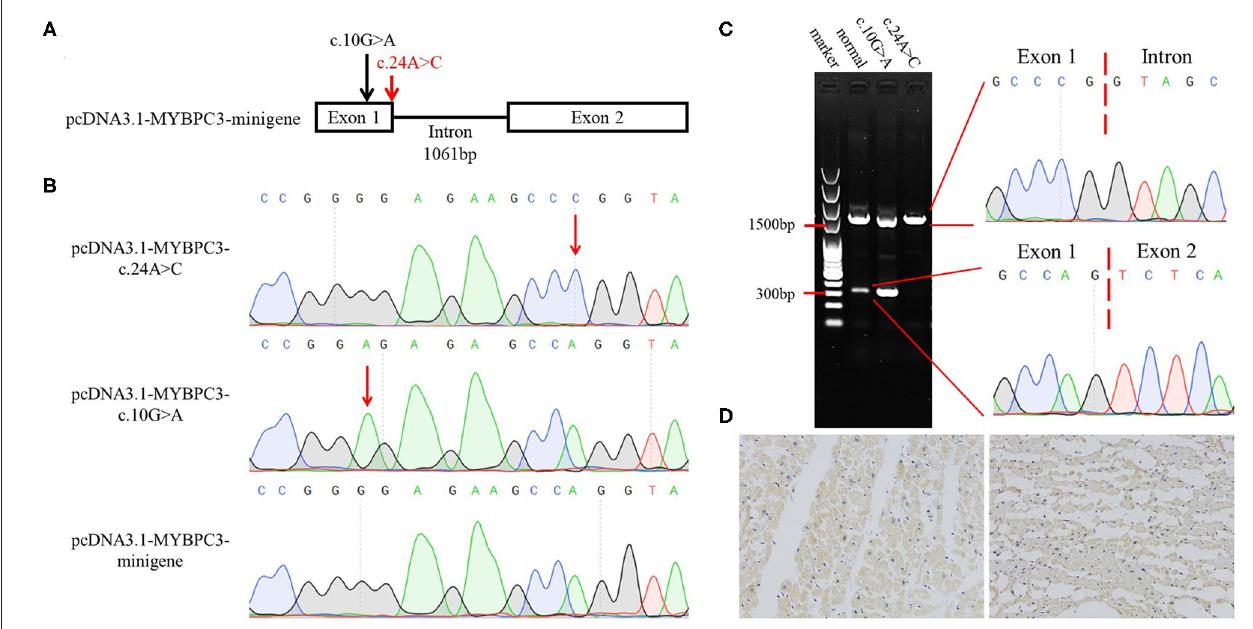
FIGURE 2 | Verification of the pathogenicity of the MYBPC3 variant (c.24A > C, p.P8P). (A) The schematic diagram of minigene models. Arrows indicate variant sites and red represents the variant detected in this study. (B) Identification of minigene models by Sanger sequencing. (C) Agarose gel electrophoresis and Sanger sequencing showing that c.24A > C results in the splicing alteration. (D) Immunohistochemistry staining of MYBPC3. Left represents the left ventricle section of the deceased with natural death, and right represents